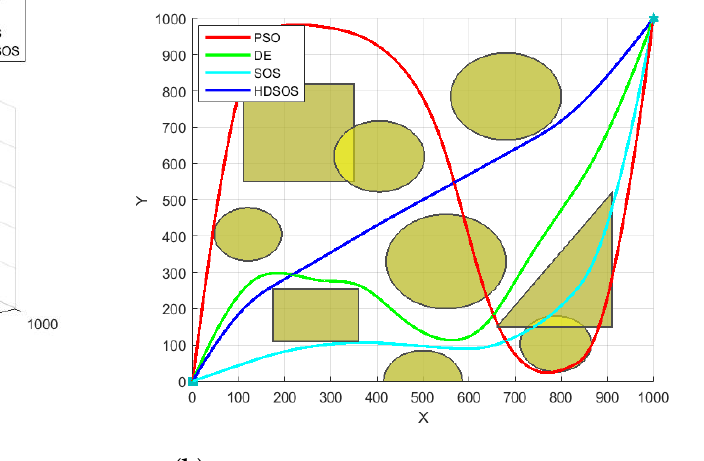
( a ) The comparative path planning results in scenario G. ( b ) X-Y view of the comparison in scenario G.